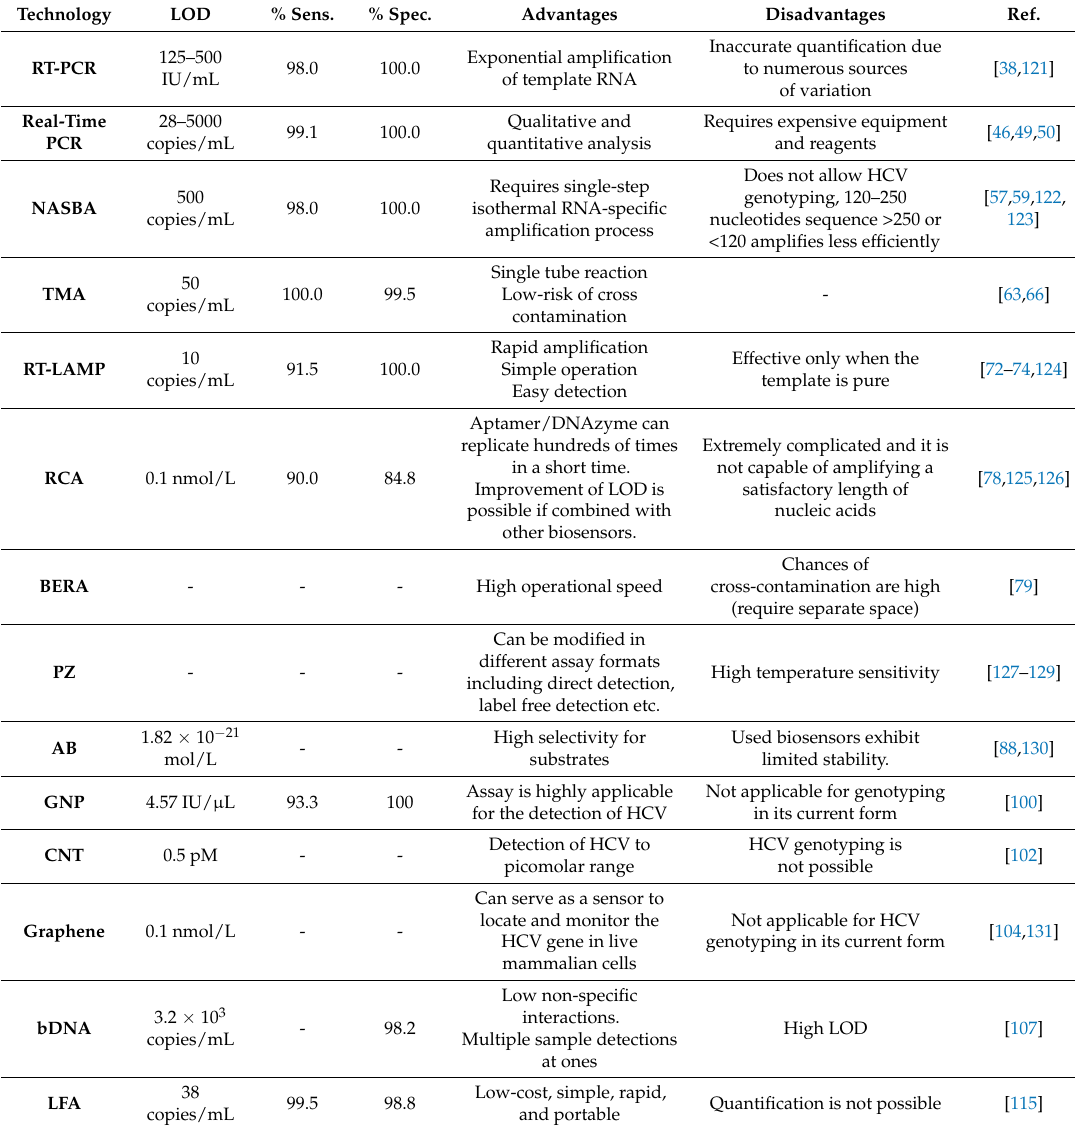
Table 2. Comparison of different methods used for the detection and genotyping of